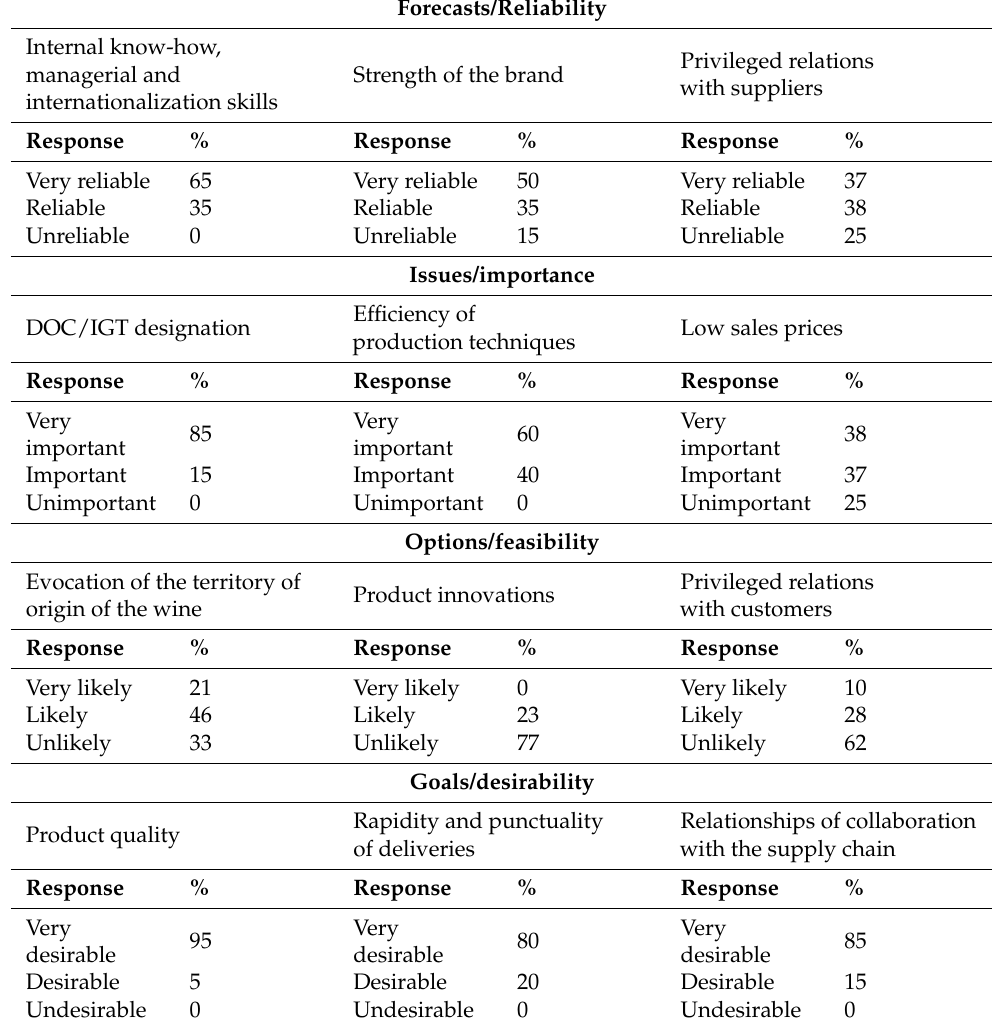
Table 5. Variables for each category with evaluations by